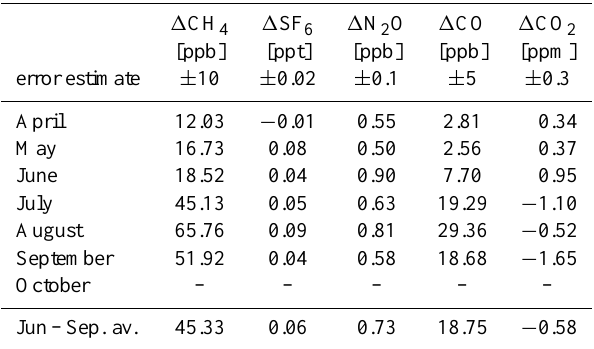
Table 1. Enhancement of CH 4 , SF 6 , N 2 O, and CO 2 during the monsoon period, integrating along the CARIBIC flight track. No plume is observed in